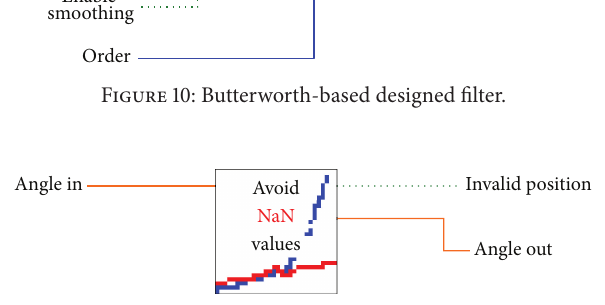
Figure 11: Avoid invalid position